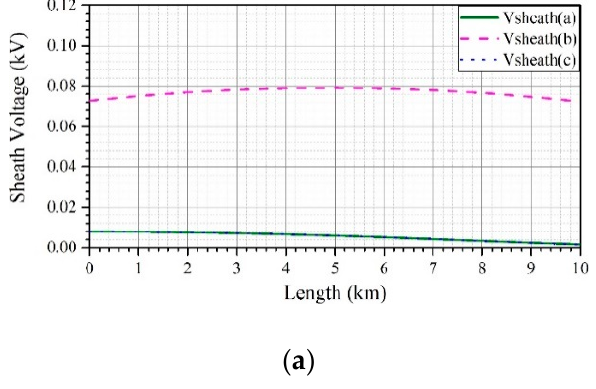
Figure 9. ( a ) Dominant harmonic voltage sources are connected in series and applied at the sending end of 10 km cable ( b ) DC and dominant harmonic voltage sources are connected in series and applied at the sending end of 10 km cable. ( c ) Accurate value of sheath voltage is determined by subtracting the respective DC components. Accurate value of sheath current is also determined in a similar manner.